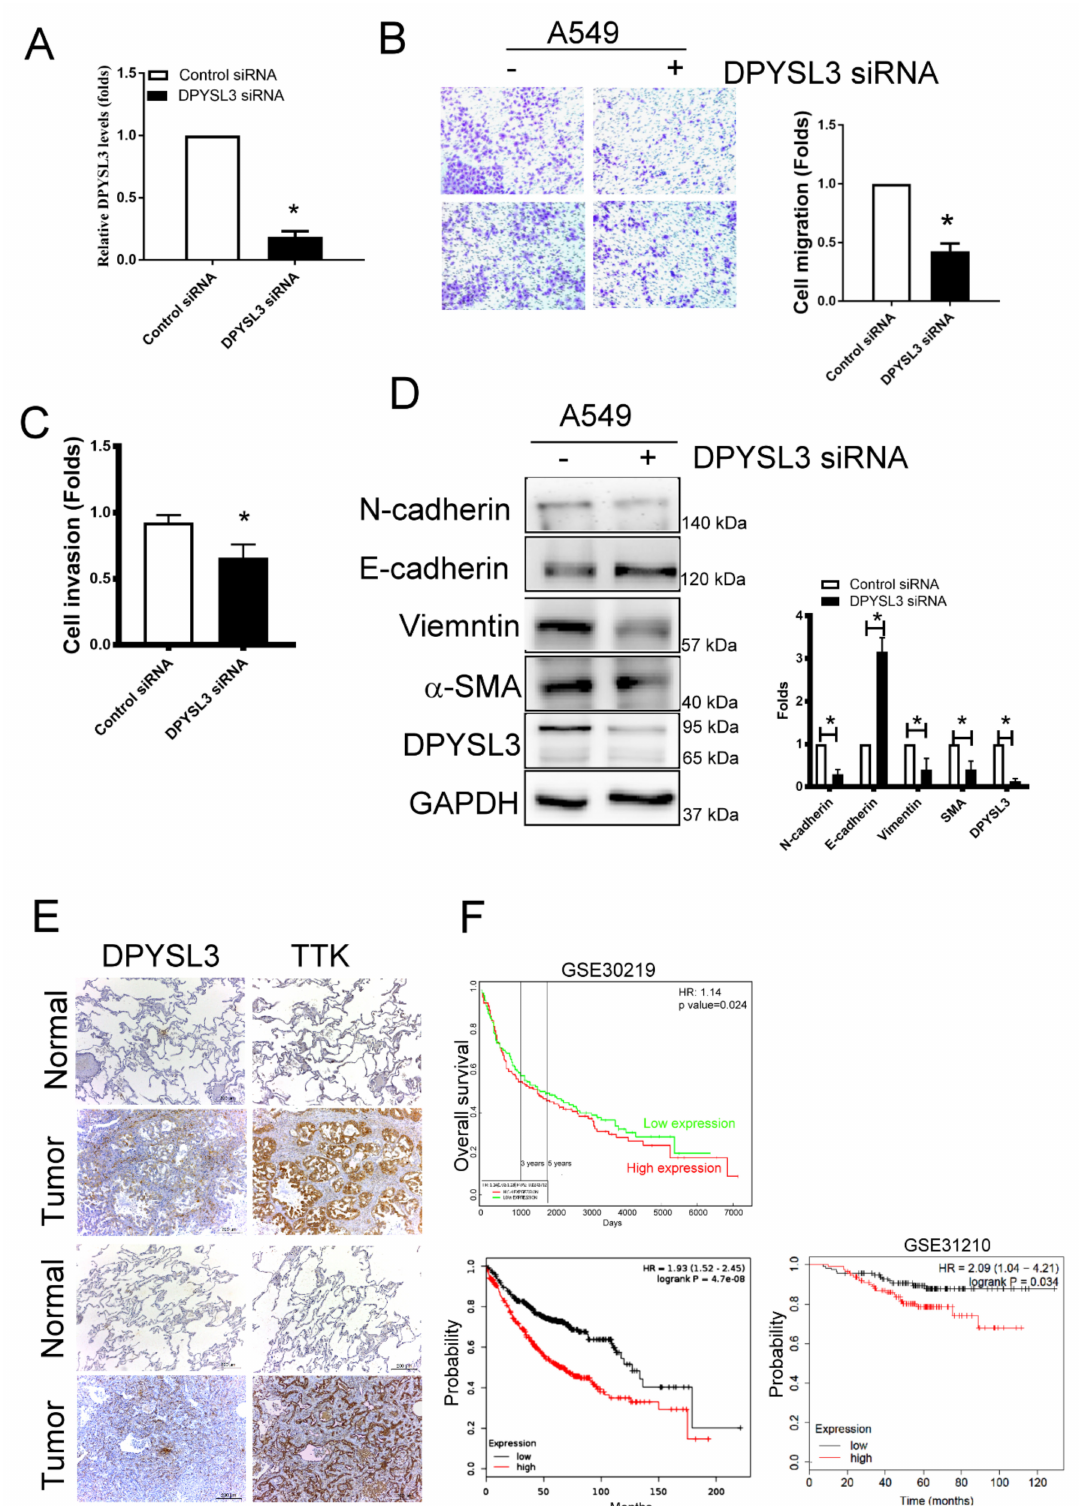
Figure 6. DPYSL3 regulated cell migration and EMT. ( A ) The e ffi cacy of DPYSL3 siRNA transfection. A549 cells were transfected either with control or DPYSL3 siRNA for 24 h. The level of DPYSL3 was determined by qRT-PCR. Inhibition of DPYSL3 decreased cell migration, as determined by the